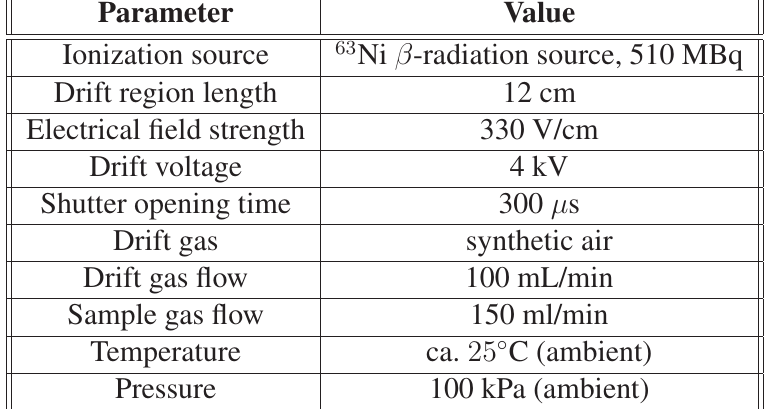
Table 1: Main parameters of 63 Ni Ion mobility